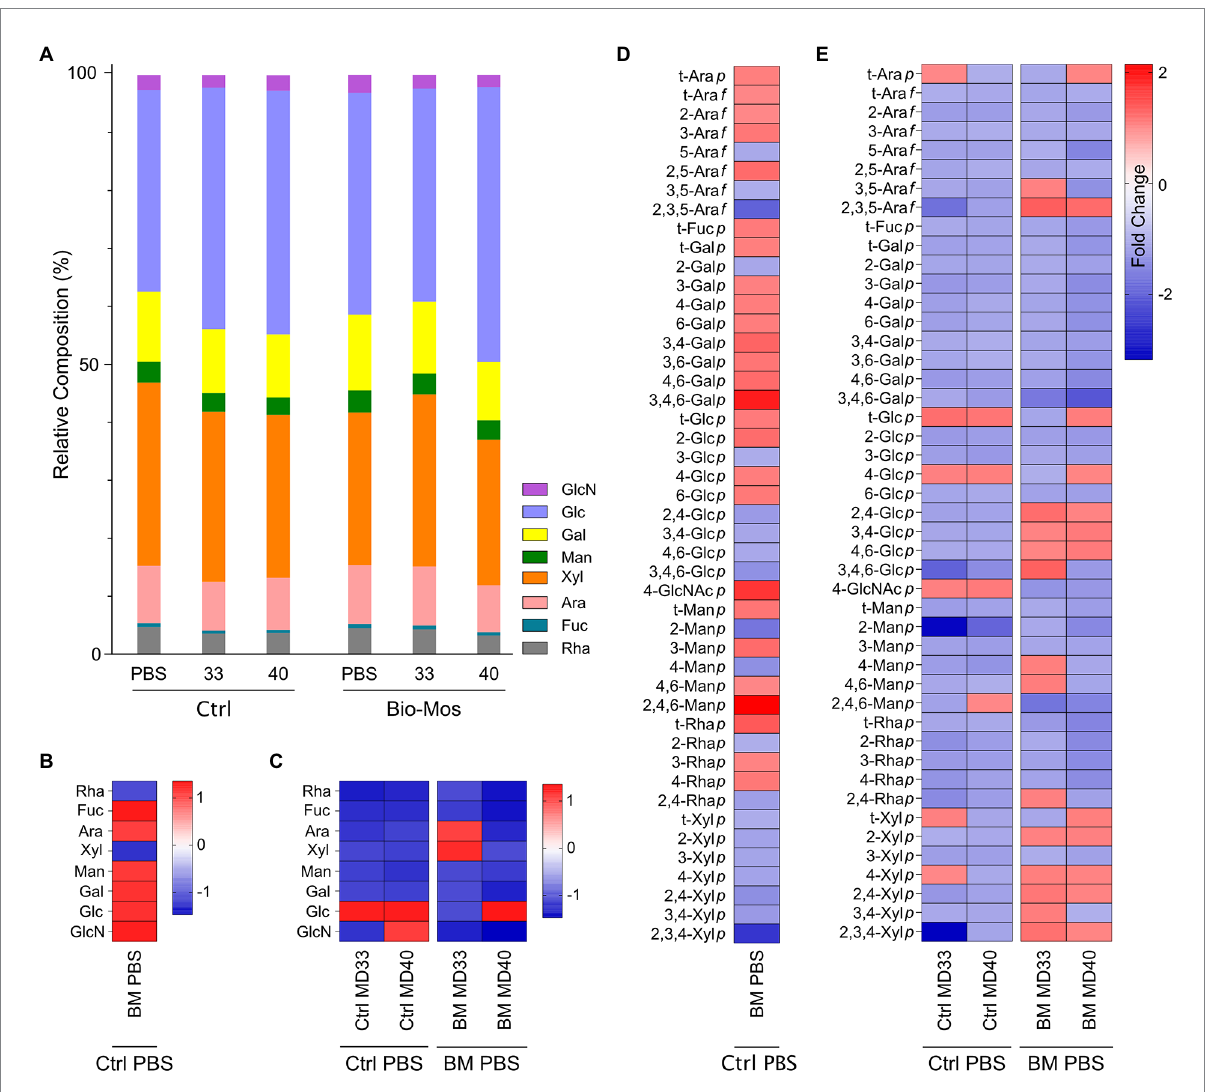
FIGURE 3 Glycomics analysis of indigestible polysaccharide residue in ex vivo rumen communities. (A) Non-crystalline cell wall monosaccharide composition. Values are averages from two cows in each diet group, with three separate experiments conducted to rumen fluid collected from each cow. Fold changes in monosaccharide compositions of the (B) Bio-Mos® PBS treatment relative to the control PBS treatment and (C) Control MD33 or MD40 treatments relative to the control PBS treatment (left) or the Bio-Mos® MD33 or MD40 treatment relative to the Bio- Mos® PBS treatment (right). Values in cells on the map are fold changes in monosaccharide composition between the PBS treatments and any of the five treatment groups (presented as columns) for given monosaccharides (presented as rows), calculated as the ratio of the maximum to the minimum of the linkage values of the two groups. Comparative analysis (heat map) of total cell wall linkages of indigestible residue of (D) Bio- Mos® PBS treatment relative to the control PBS treatment and (E) Control MD33 or MD40 treatments relative to the control PBS treatment (left) or the Bio-Mos® MD33 or MD40 treatment relative to the Bio-Mos® PBS treatment (right). Values in cells on the map are fold changes in linkage composition between the PBS treatments and any of the five treatment groups (presented as columns) for given linkages (presented as rows), calculated as the ratio of the maximum to the minimum of the linkage values of the two groups. A value with a warm color (positive change number) signifies an increase in the associated monosaccharide or linkage in that sample; a value with a cold color (negative change number) signifies a decrease in the associated monosaccharide or linkage in that